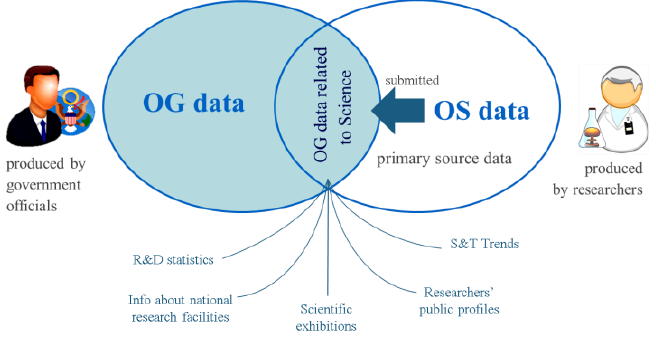
Fig. 7. Relationship between OS data and OG